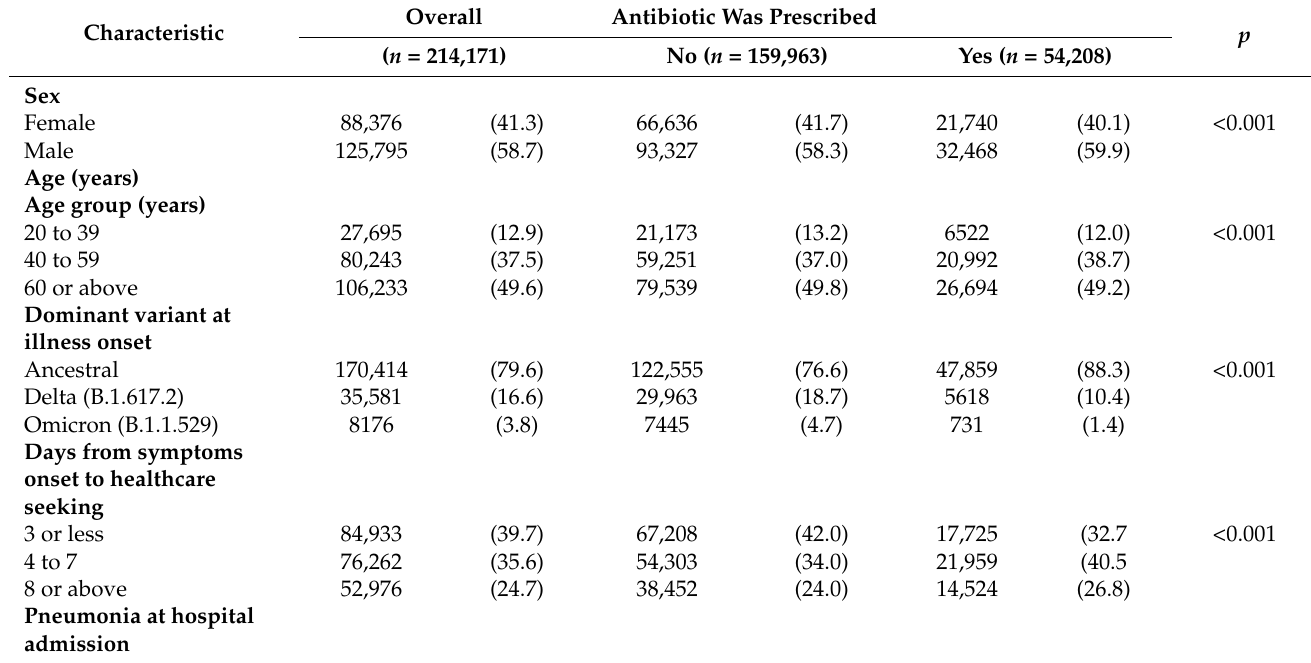
Table 1. Characteristics of the study sample for selected variables, Mexico 2020–2022.